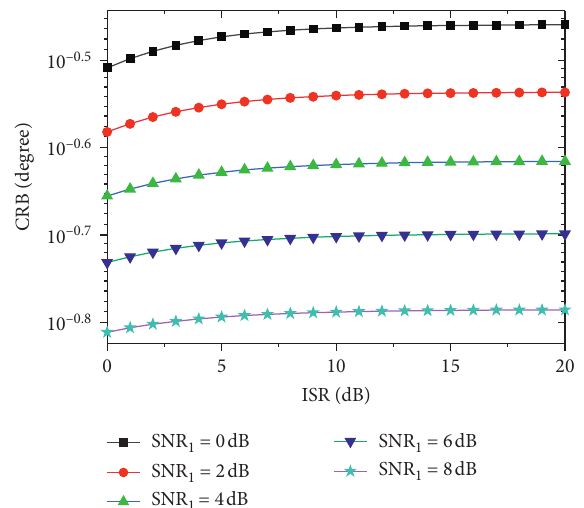
Figure 2: The CRBs of the weak source against the ISR under different SNR 1 .